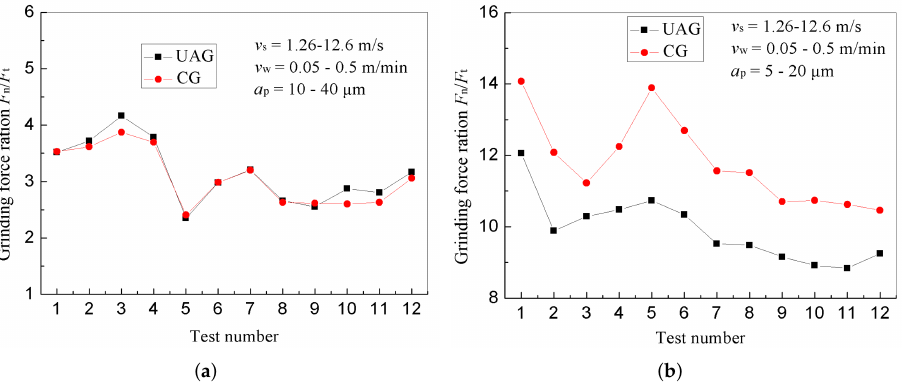
Figure 12. ( a ) Side grinding force ratio. ( b ) End grinding force